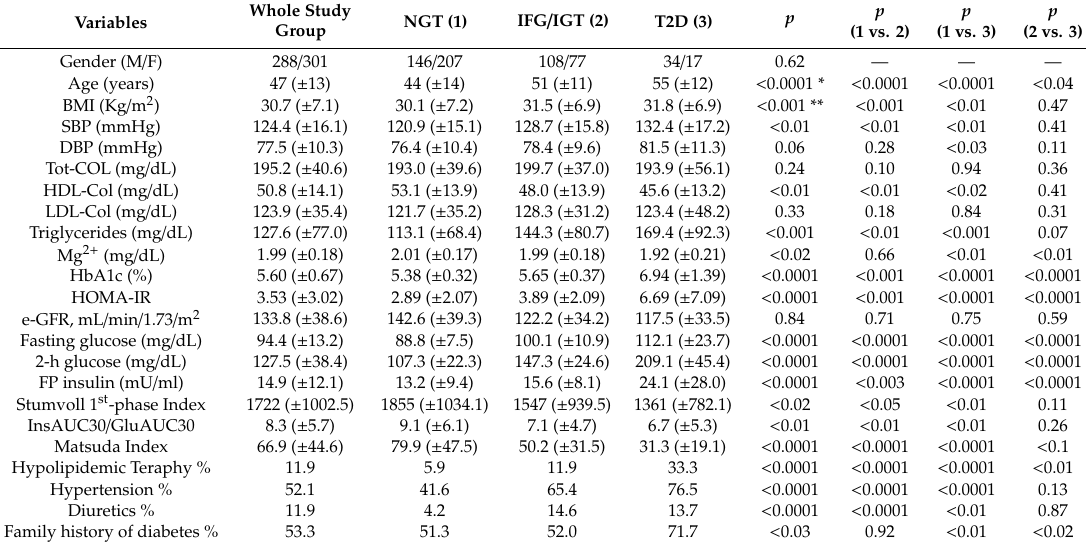
Table 1. Anthropometric and metabolic characteristics of the study subjects stratified according to American Diabetes Association (ADA) criteria for the classification of glucose tolerance.